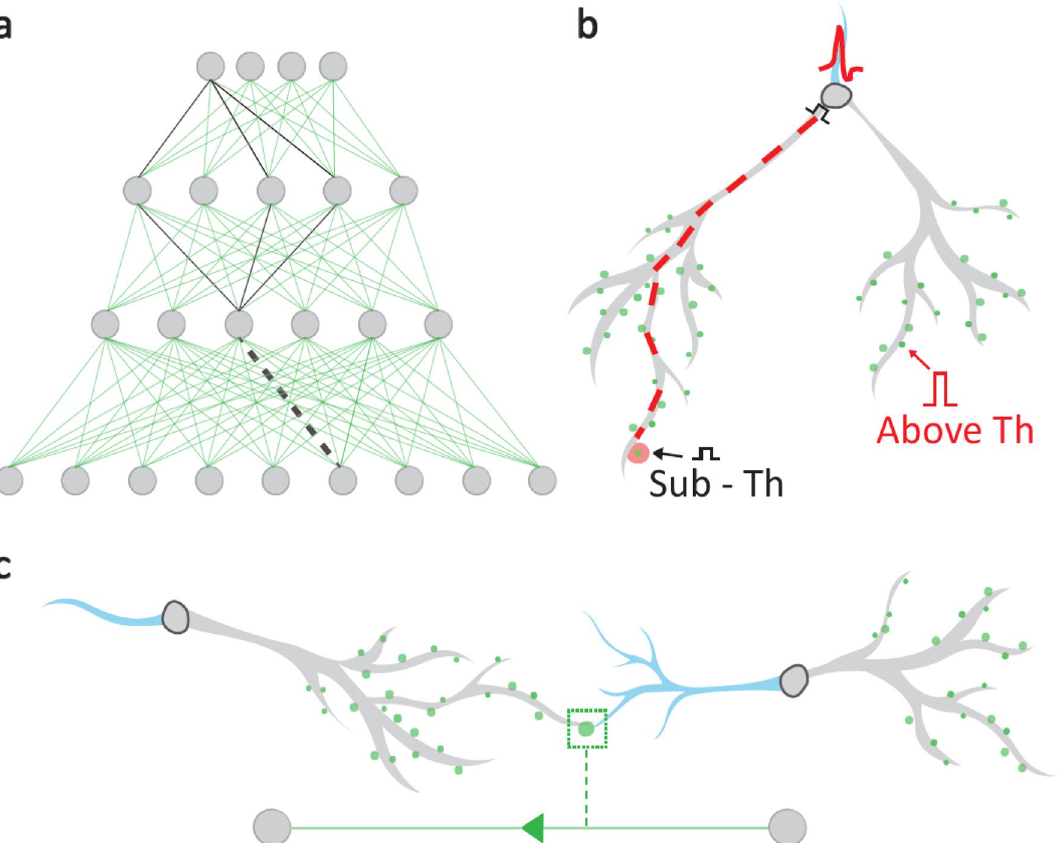
Figure 1. From a biological learning scheme to ANNs. ( a ) Scheme of two hidden layers of a feedforward network, where several routes (black) connect an output unit to a weight (black dashed line). ( b ) Scheme of a neuron (node in a ) with two dendrites (gray), an axon (blue), and multiple synapses (green circles). A sub- threshold synaptic stimulation (black) via the left dendrite arrives at the soma after a spike (red) was generated through an above-threshold synaptic stimulation via the right dendrite, thereby strengthening the left synapse (enlarged red circle) via a backpropagation signal (red dashed line). ( c ) Biological scheme of the right neuron connecting to the left neuron via axon/synapse/dendrite (blue/green-circle/gray). Artificial scheme as in a